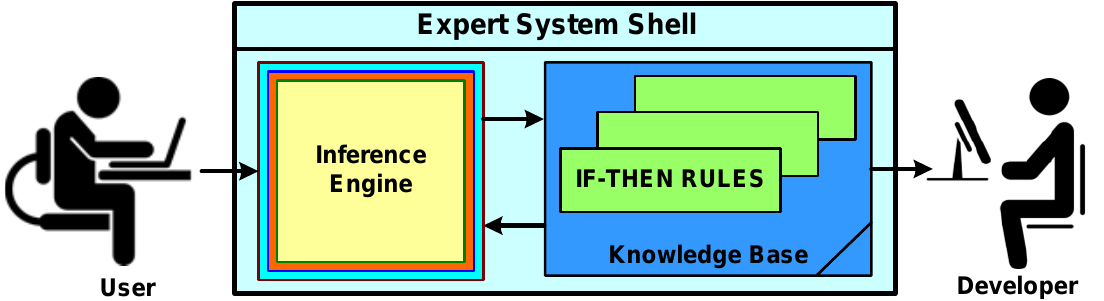
Figure 13. Configuration of an expert system (adapted from [93]).